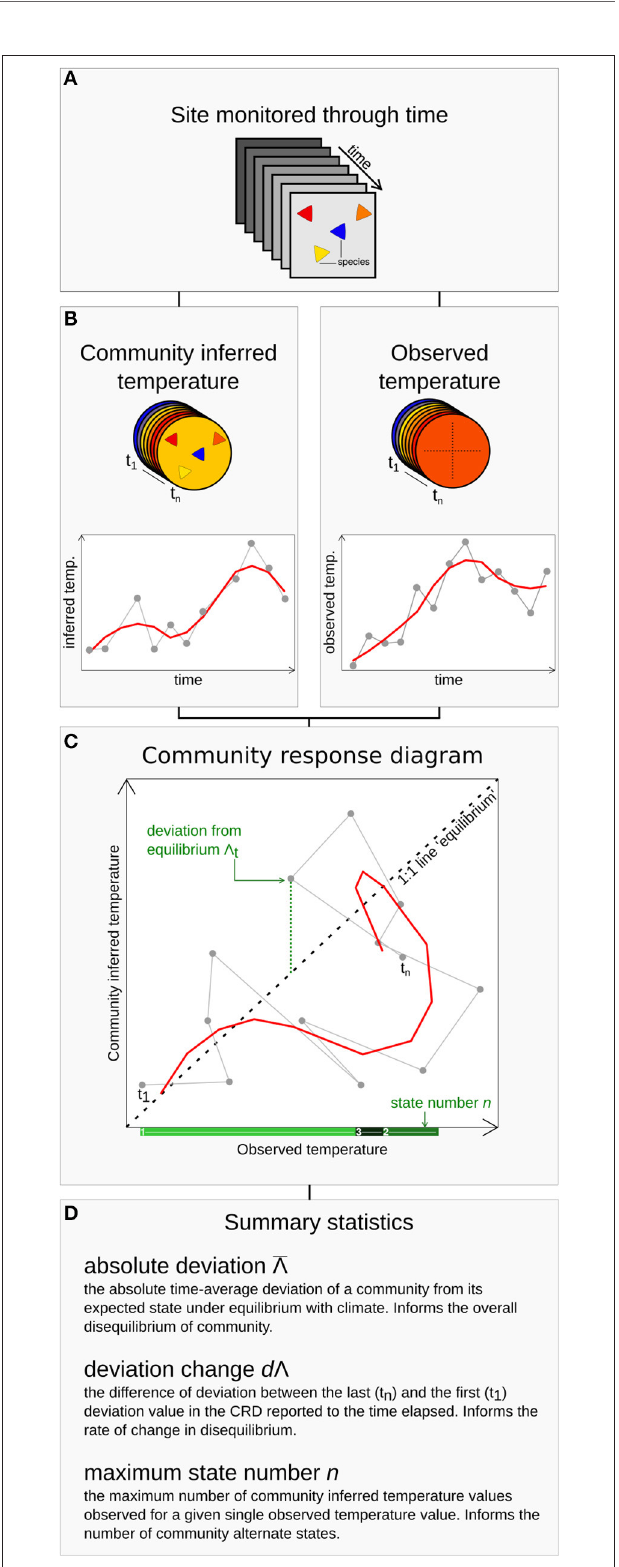
FIGURE 1 | Summary of the community response diagram (CRD) framework. Data on community composition of a given site through time (A) are used to